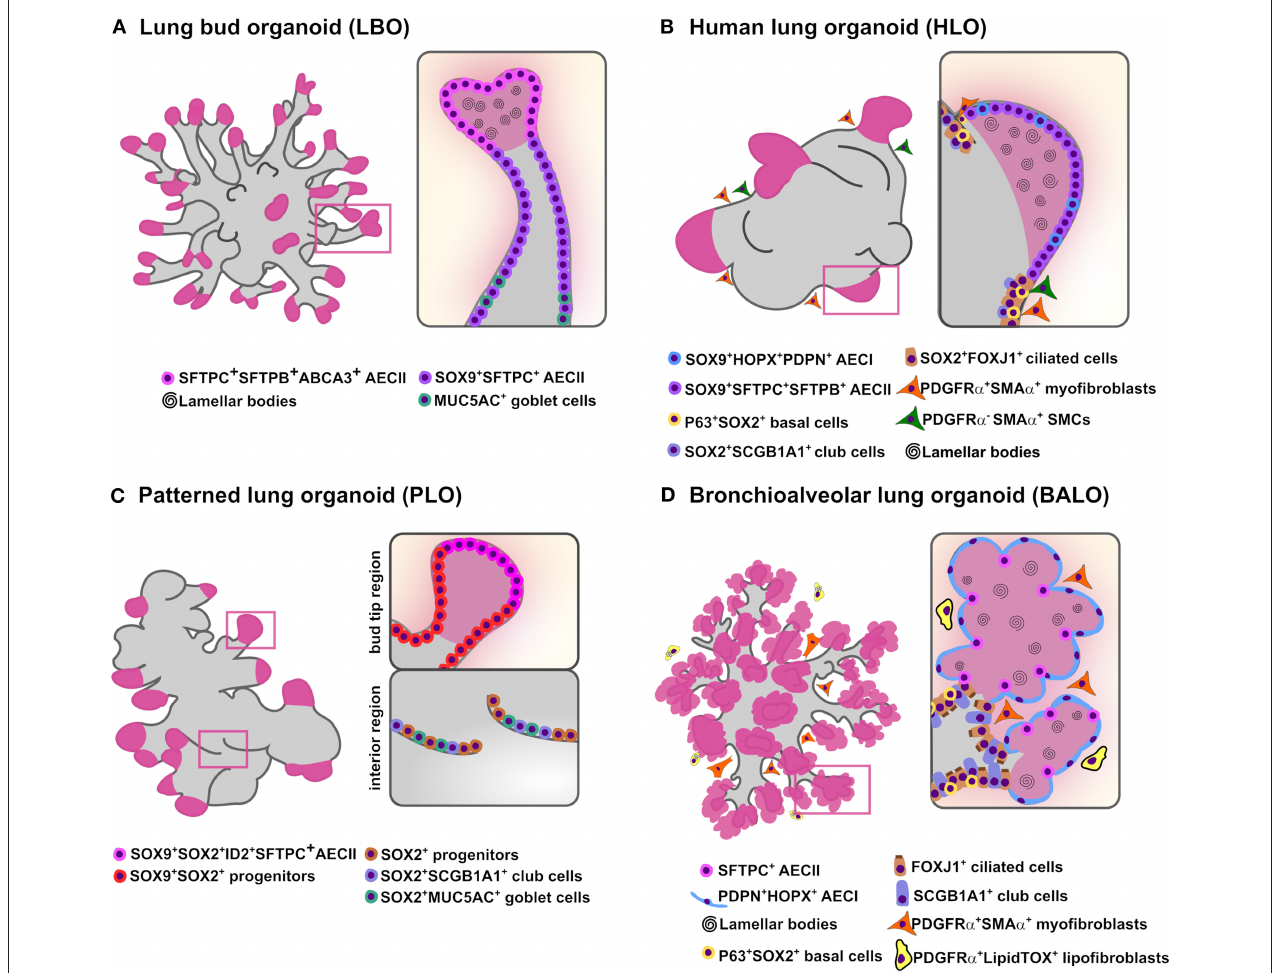
FIGURE 1 | In vitro branching lung organoid models. Schematic representation of the current lung organoids models showing proximodistal specification and bud/branching formation in vitro derived from hPSCs and murine adult stem cells. (A) Lung bud organoids (LBO) are derived from hPSCs and have several cells expressing AECII markers SFTPC, SFTPB, and ABCA3 while airway goblet cell markers MUC5AC and MUC5AB are rare. While most cells co-expressed SOX9 + the pheripheral luminal cells expressed only mature AECII markers (MUC1, SPTPC, SFTPB, ABCA3) containing lamellar bodies (B) Human lung organoids (HLO) are derived from hPSCs and display proximal airways, expressing proximal cell type-specific markers for basal cells (P63), ciliated cells (FOXJ1) and club cells (SCGB1A1) co-expressing SOX2; distal-like structures expressing SFTPC/SFTPB AECII and PDPN/HOPX AECI cell-type markers mostly co-stained with SOX9. Lamellar bodies are found inside and outside the SFTPC + AECII-like cells while SMA + PDGFR α + (myofibroblasts) and SMA + PDGFR α − [smooth muscle cells (SMCs)] are observed in close proximity to the epithelial tube-like structures. (C) Patterned lung organoid (PLO) are derived from hPSCs and have peripheral regions that contain cells co-expressing SOX9/SOX2, some also SFTPC and ID2 while internal regions only express SOX2 with some cells expressing the club cells marker SCGB1A1 and goblet cells marker MUC5AC. (D) Bronchioalveolar lung organoids (BALO) are derived from BASC isolated from the lung of adult mice and possess proximal tubular structures containing club/secretory cells (SCGB1A1), basal cells (P63), ciliated cells ( β -4 tubulin) and distal alveolar-like structures are composed of AECII (SFTPC) and AECI (PDPN). Lamellar bodies are observed in AECII and in the lumen. Myofibroblasts (PDGFR α high α SMA + ) are observed close to BALO’s branching points while lipofibroblasts (PDGFR α low LipidTOX + ) are observed in close proximity to